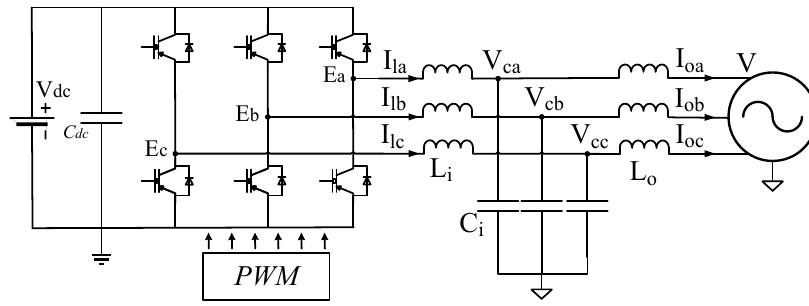
Figure 2. Three-phase generator connected to a voltage source.